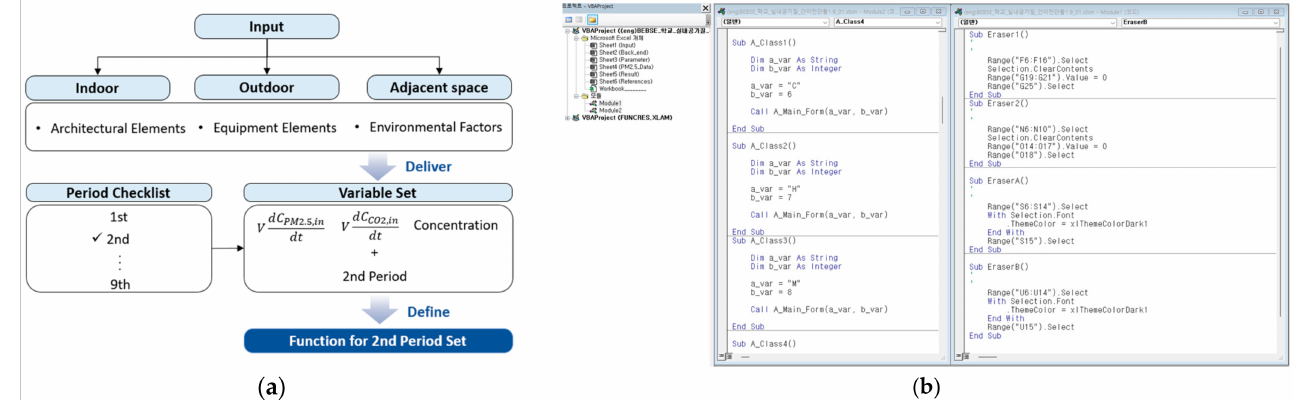
Figure 11. ( a ) Program development process by class period using VBA and a macro, a Microsoft Excel development tool. ( b ) Microsoft Excel development tool, VBA screen.